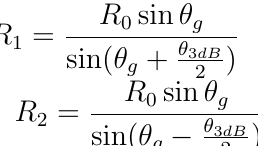
= 15 m , I = 65 dB ), θ = 3–12 ◦ ( a ); Change in the footprint and 0 R 0 g while R is kept constant ( b g 0